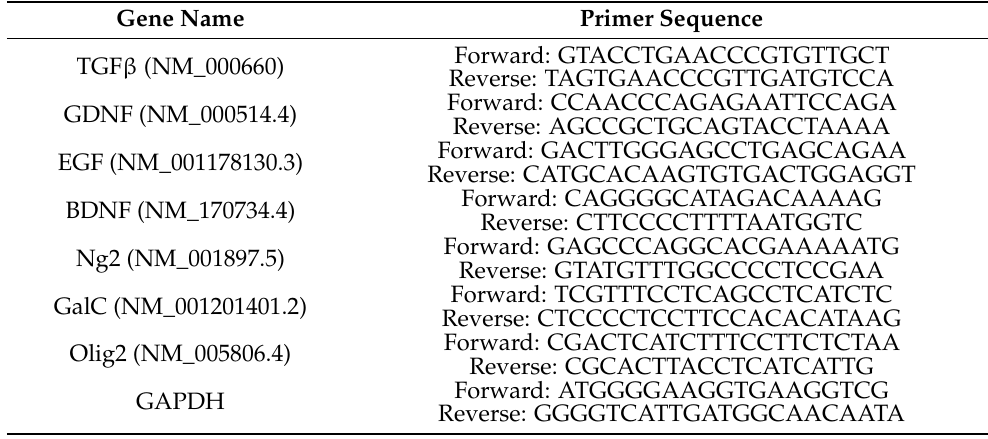
Table 1. Primers used in real-time PCR